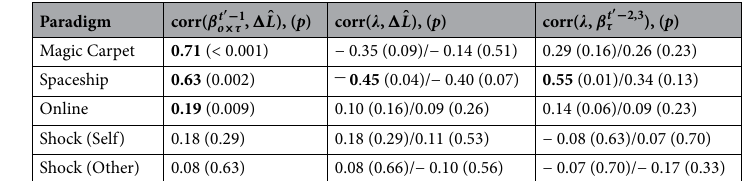
Table 1. Correlation analyses. Correlation coefficients and uncorrected, associated p values. Due to (cid:31) not being normally distributed, both Pearson’s r using log-transformed data (left) and Spearman’s r (right) using ′ − 1 untransformed data are presented for its analyses. β t o × τ : regression beta-coefficient for the interaction between outcome and transition type for the preceding trial, (cid:31) ˆ L : difference in values of maximized log likelihood ′ − 2,3 function for the Hybrid-RL and best fitting active inference model, β t τ : beta-coefficient encoding the main effect of transition type at the second and third previous trials. Significant values are in